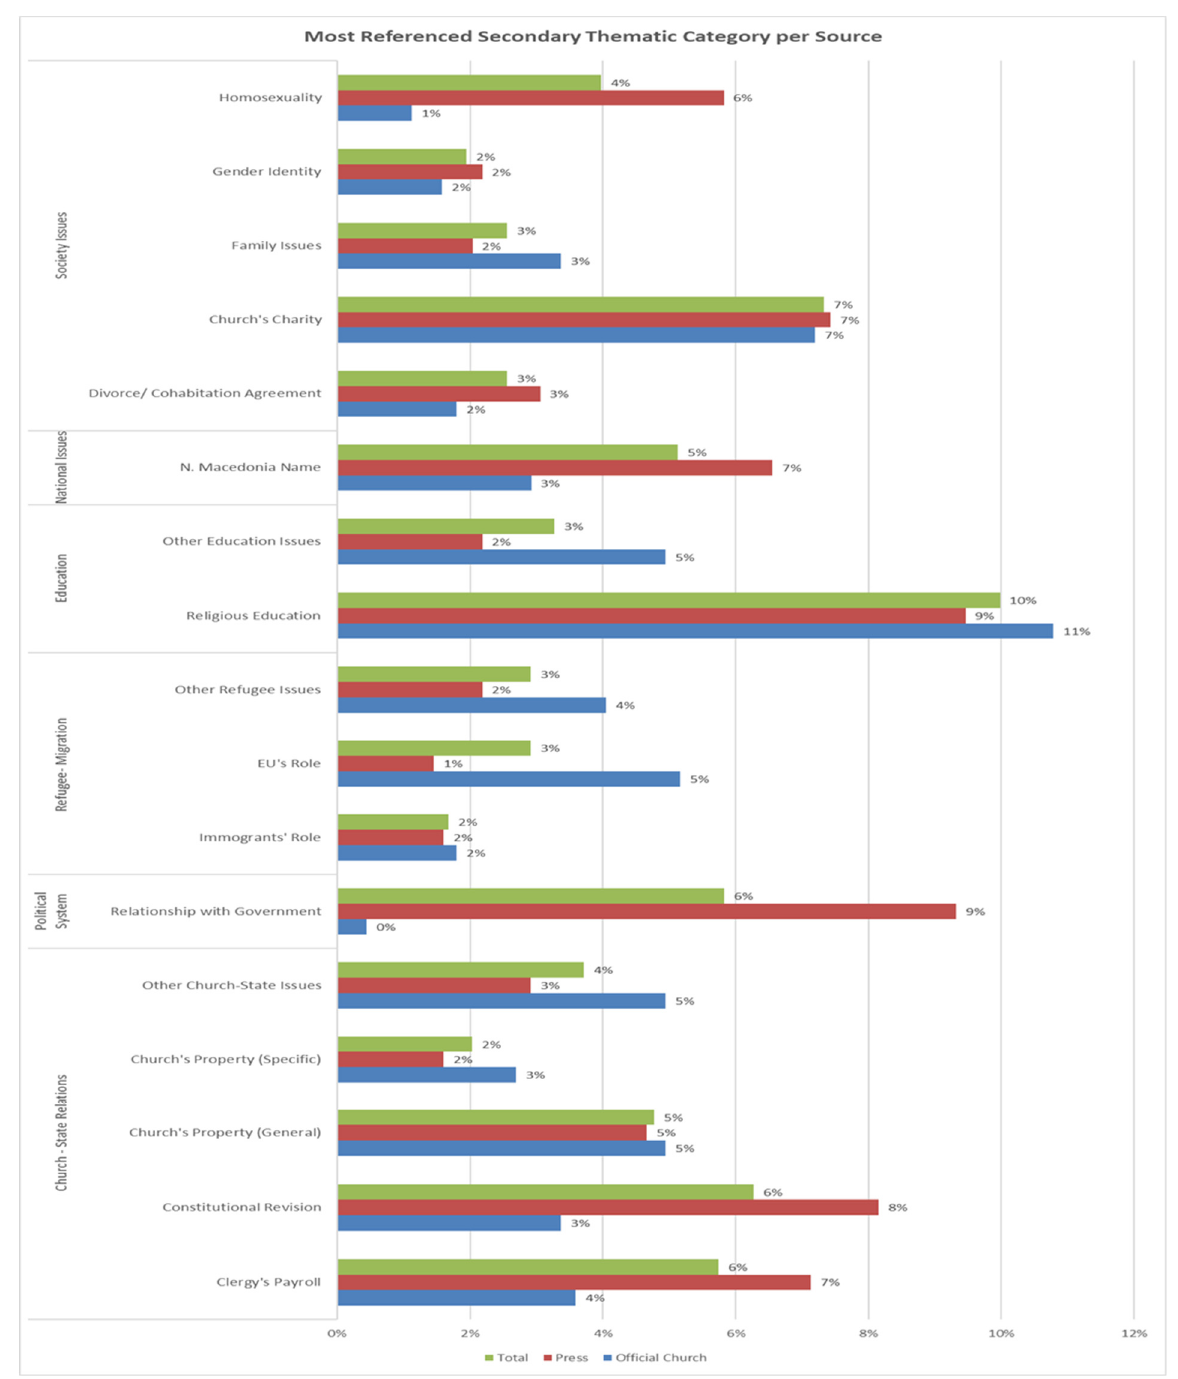
Figure 2. Most referenced secondary thematic categories per source. Source: official website of the CoG (www.ecclesia.gr, accessed on 17 March 2022) and newspapers (EFSYN and Kathimerini). Where the height of the bars with the same figures is slightly differentiated, this is due to the value rounding process performed by the statistical program used for the current research (IBM